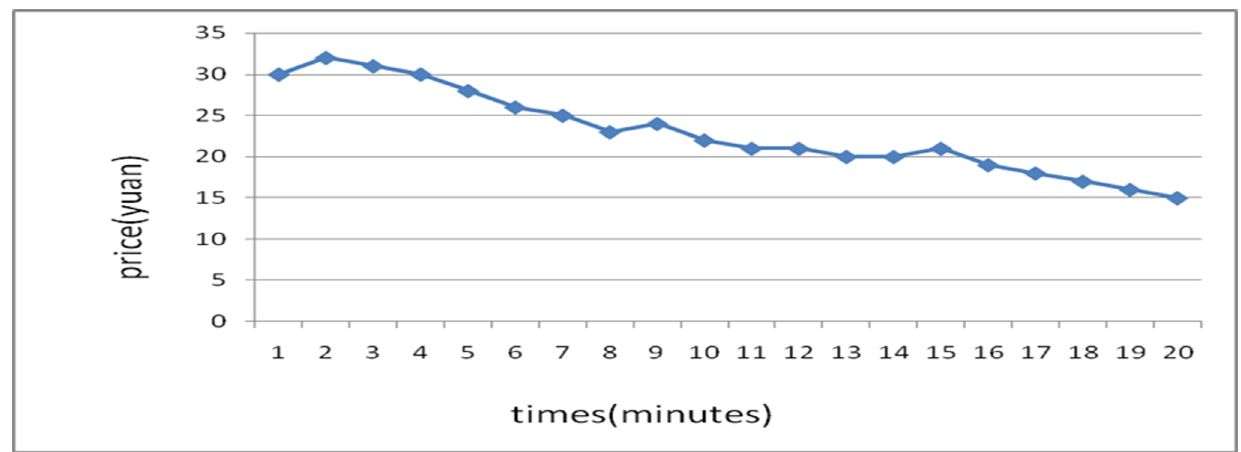
Figure 7. Experiment of a Unilaterally Price-Falling Situation with Manipulation.